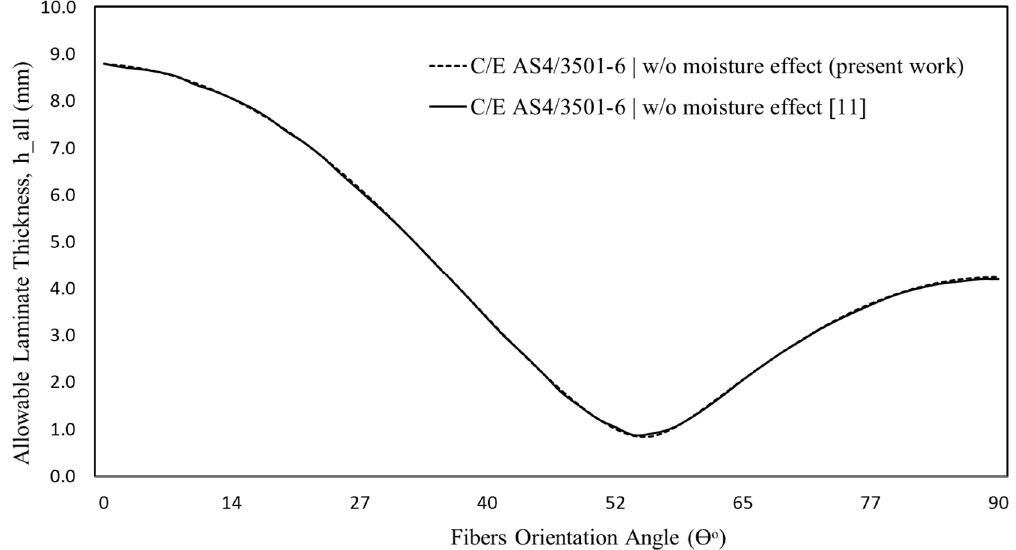
Figure 4. Verification of analytical solution and the MATLAB program developed in the present work. The lay-up is (± θ )ns and the PV size is 63.5 mm in diameter and 400 mm in length.